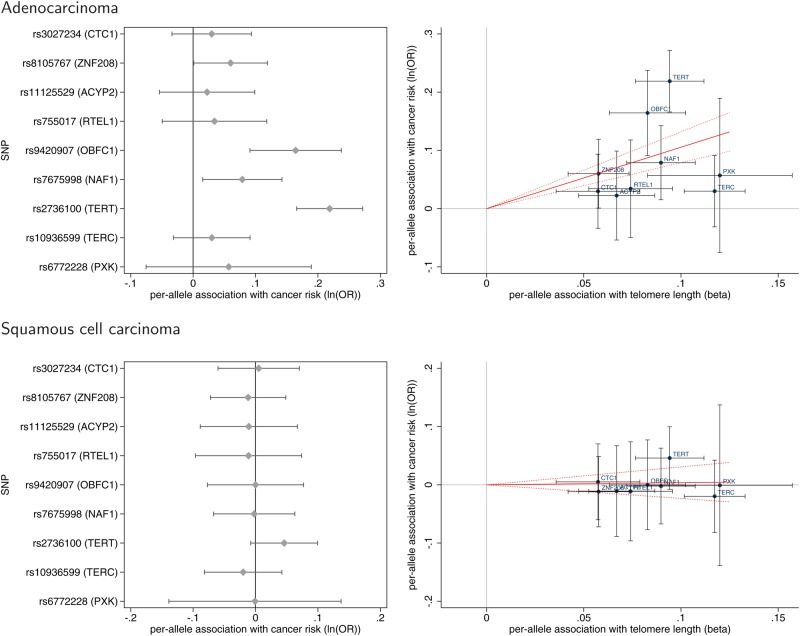
Forest plots (left) and scatter plots (right) of associations between TL-associated SNPs and risk for lung adenocarcinoma (top) and squamous cell carcinoma (bottom). Forest plots show association estimates (with horizontal bars indicating 95% CI) for the ‘long telomere’ allele of each SNP with cancer risk. SNPs are ordered by increasing magnitude of association with TL. Scatter plots show the per-allele association with cancer risk plotted against the per-allele association with kb of TL (with vertical and horizontal black lines showing 95% cCI for each SNP). The scatter plot is overlaid with the Mendelian randomization estimate (slope of red solid line with dotted lines showing 95% CI) of the effect of TL on cancer risk